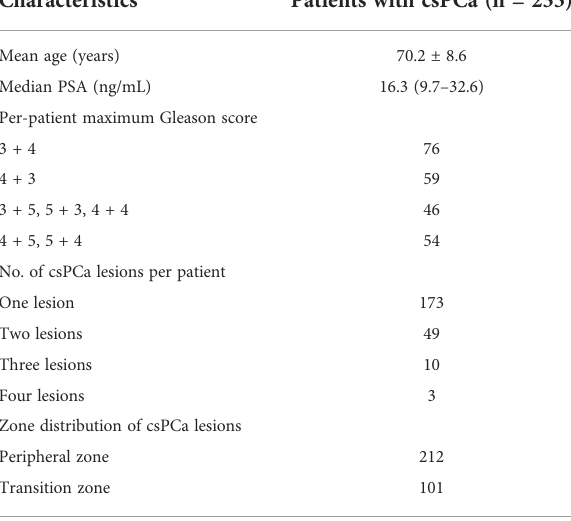
TABLE 1 Characteristics of patients with csPCa.